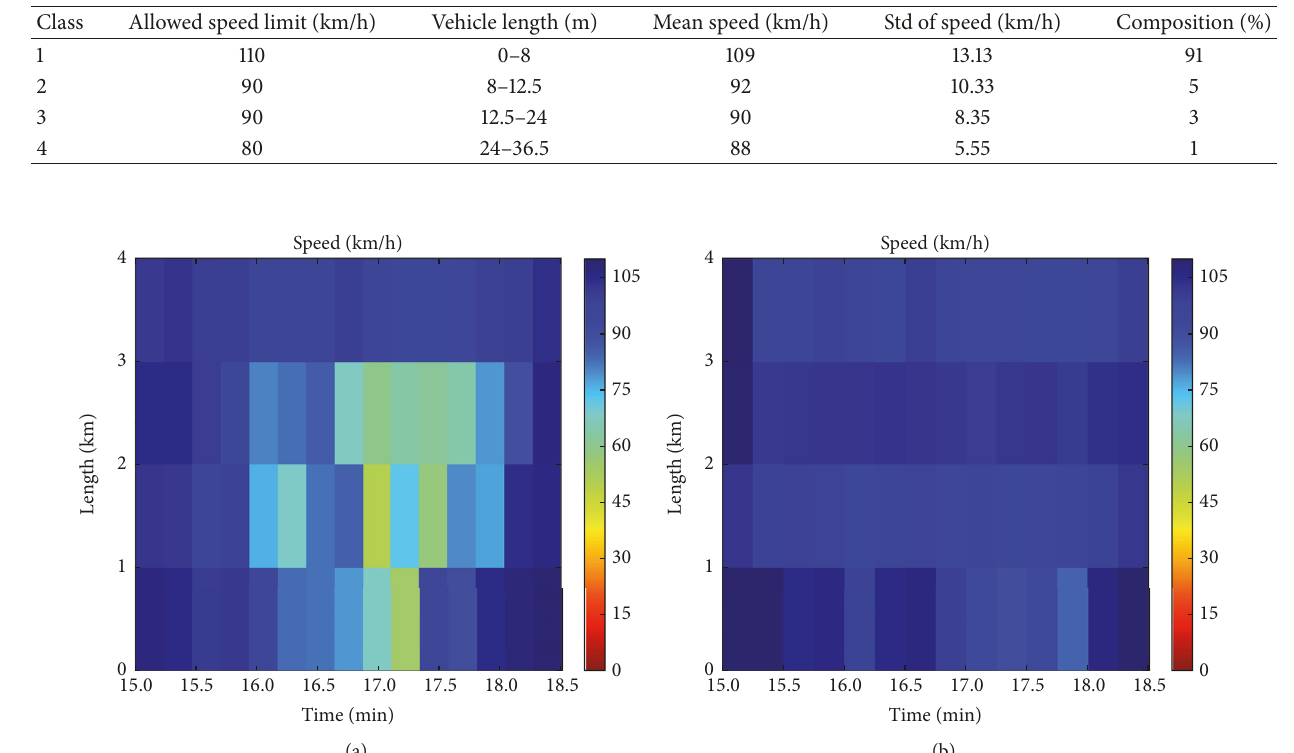
Table 2: Free flow speed distribution for the different vehicle classes.